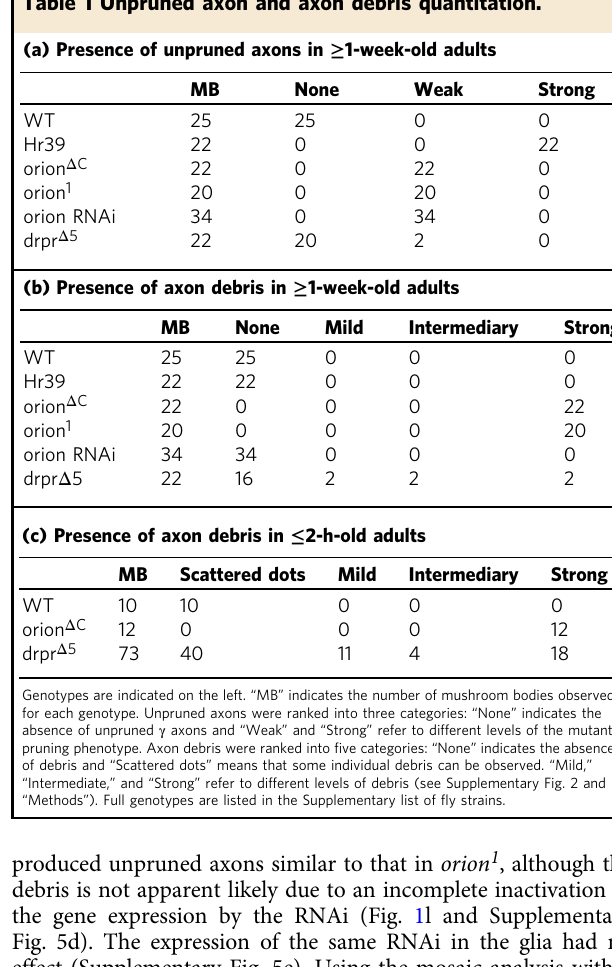
Table 1 Unpruned axon and axon debris quantitation.